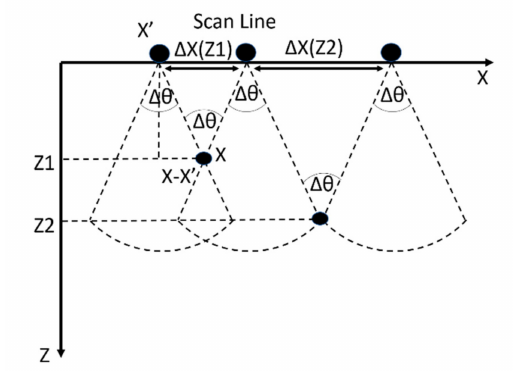
Figure 1. Beamwidth angle ∆ θ for a point scatterer at depth Z ; when the point scatterer is deeper Z2 > Z1 , the synthetic aperture size ( ∆ X ) changes accordingly. The apodization window size should be adapted to the synthetic aperture window